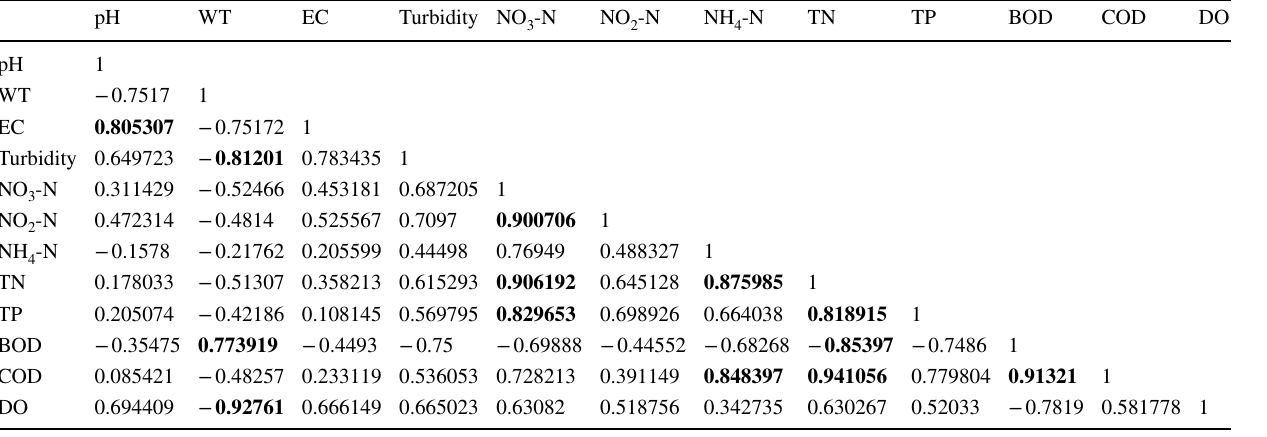
Table 4 Correlation matrix of the physicochemical parameters during dry season